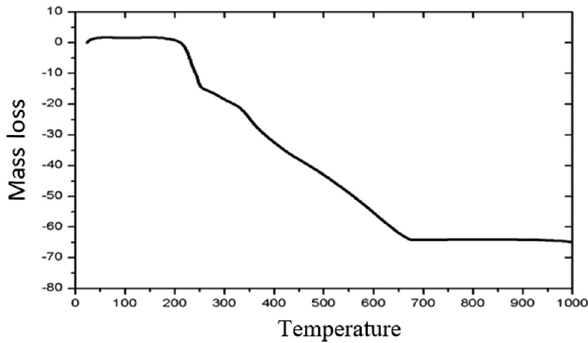
Figure 7: TG analysis of the compound [ Zr ( C 12 H 17 N 4 O 4 S 2 ) 2 ] 2 + · 2 ( NO 3 ) − at a heating rate of